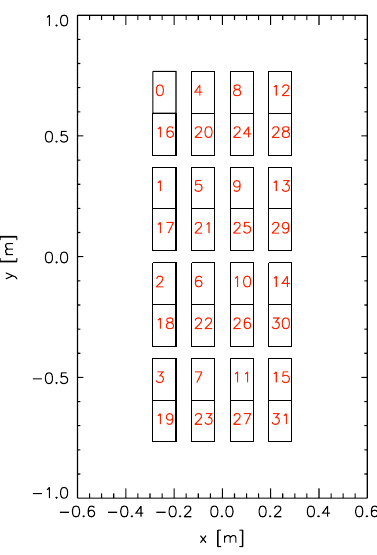
FIG. 5. Scheme of the pixels used for the tomographic recon- struction. The configuration with 32 pixels is shown (each beamlet group is divided into two